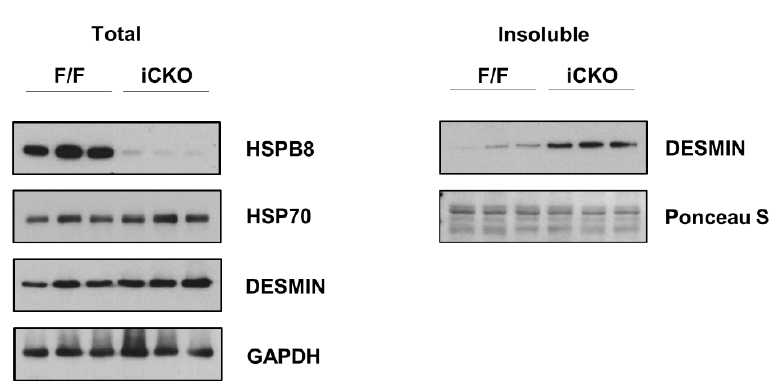
Figure 4. Decreased expression of HSPB8 and subsequent accumulation of insoluble DESMIN in cardiomyocytes in Bis -iCKO mice. Immunoblots for HSPB8, HSP70, and DESMIN in total fractions from the hearts of F/F and iCKO mice ( left ). Increased levels of DESMIN in the insoluble fraction in the hearts of iCKO mice were demonstrated using Western blotting ( right ).